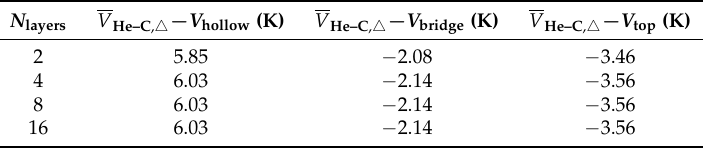
Table 8. The difference between V He–C ( z e ) and V He–C, (cid:52) ( z e ) .